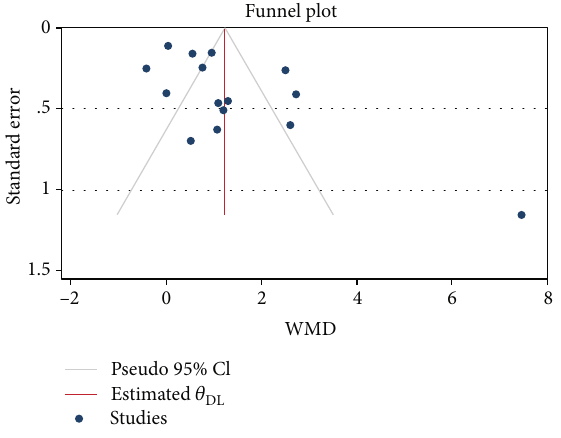
Figure 3: Funnel plot of the association between NLR and preterm